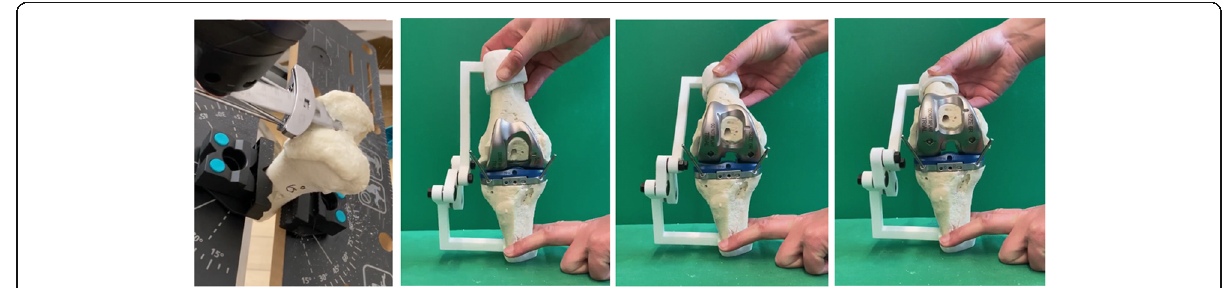
Fig. 8 Different steps of the total knee replacement surgery on the patient specific model, from left to right: femur cut, tibia cut, 0, 30 and 60 degrees of flexion after